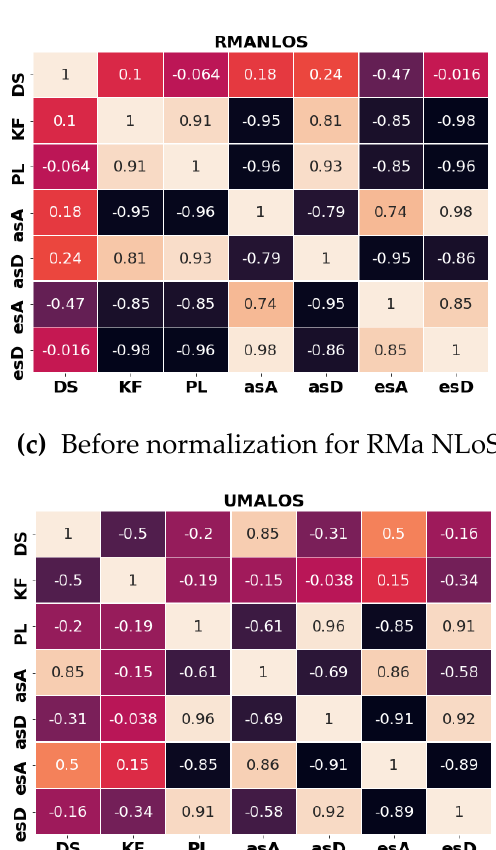
(b) After normalization for RMa LoS.